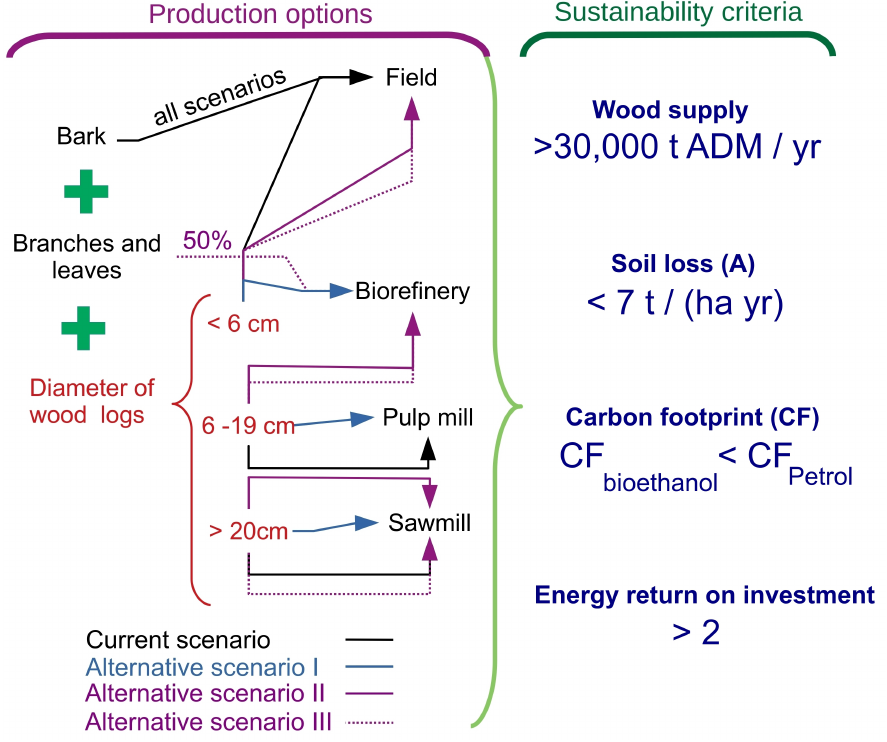
Figure 4. Production scenarios and sustainability criteria assessed. Table 3. Eucalyptus grandis wood composition expressed in percentage, according to Lima et al.